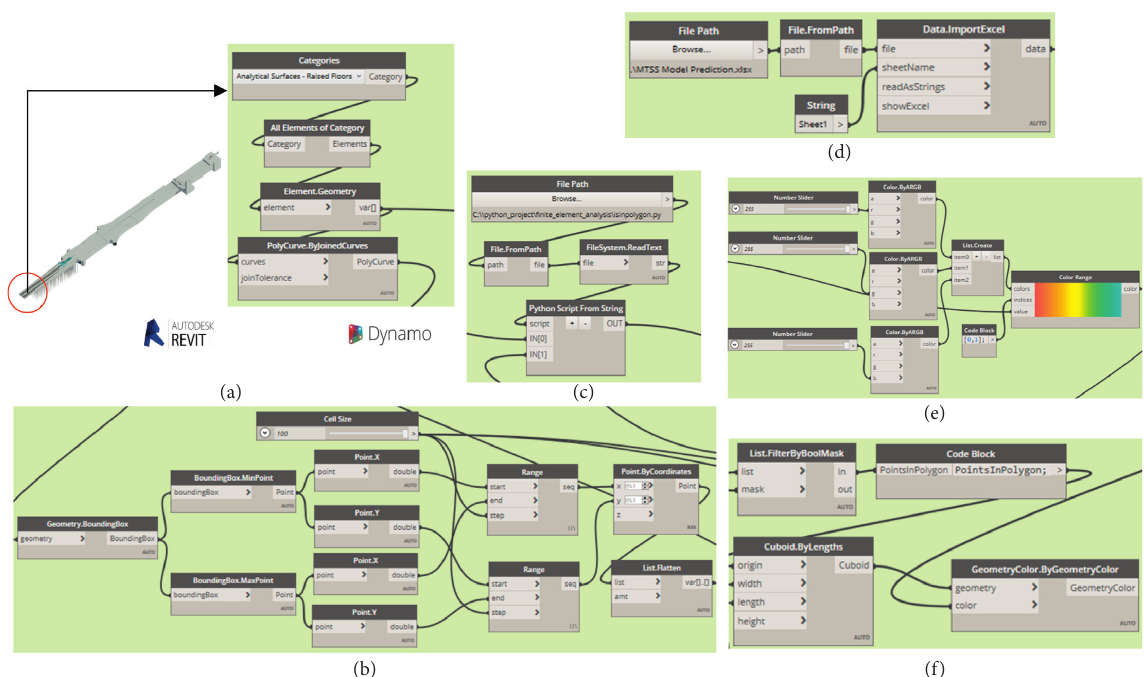
Figure 8: Dynamo’s digital twin workflow. (a) Import the Revit highway BIM model. (b) Create highway segment element. (c) Import Python script. (d) Import MTSS highway segment performance prediction results. (e) Create a chromatogram. (f) Visualize the changing trend of highway